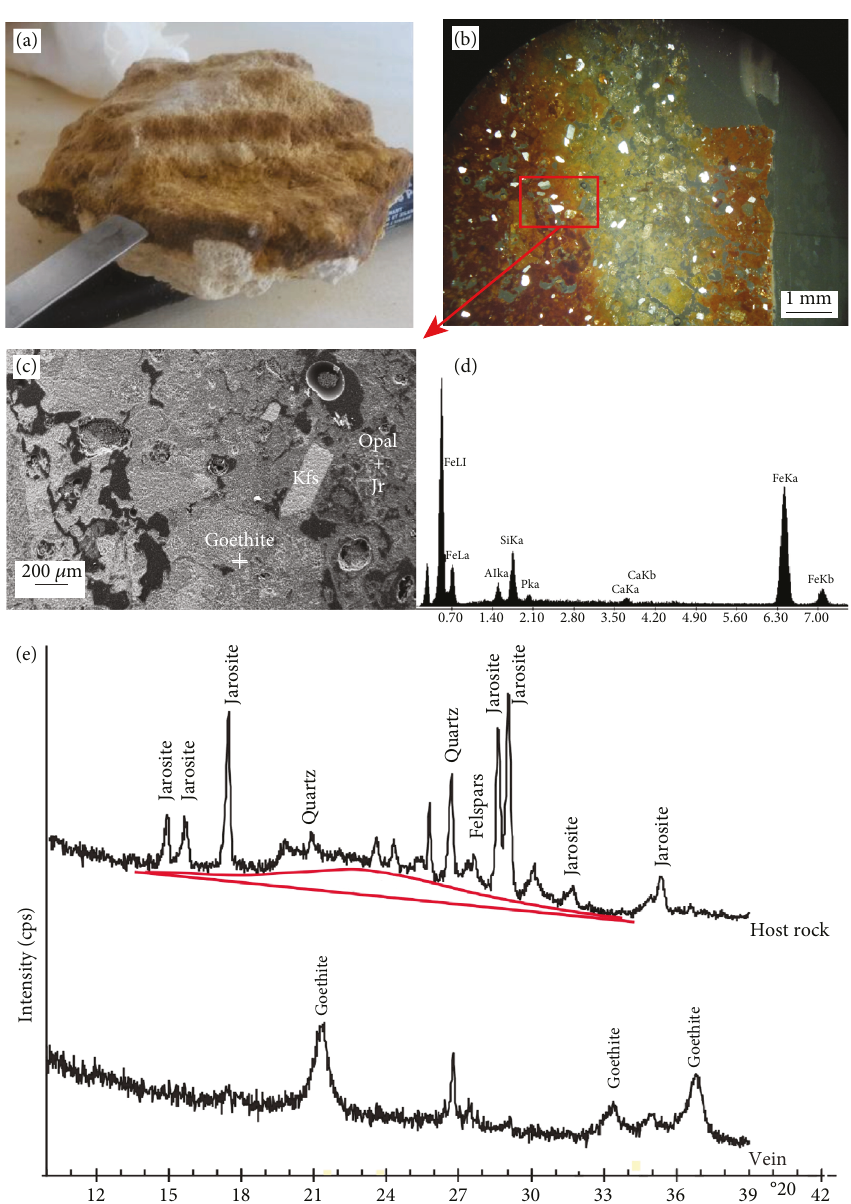
Figure 7: (a) Picture of the representative sample (yellow host rock and white vein); (b) OM observations (crossed polars); (c, d) SEM image and EDX spectra of goethite. Jr: jarosite; Qtz: quartz. (e) XRD di ff raction pro fi les of the host rock and